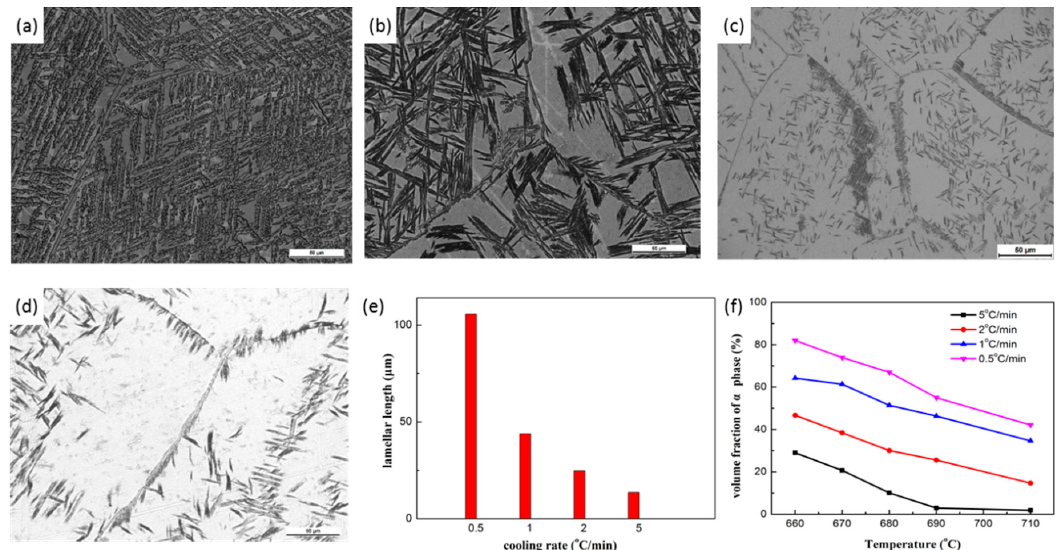
Figure 7. Effect of the cooling rate on the nucleation and growth of the α phase. The specimens were cooled at ( a ) 0.5, ( b ) 1, ( c ) 2 and ( d ) 5 °C/min from 865 °C to 660 °C. The measured length and volume faction of the α phase are given in ( e ) and ( f ).